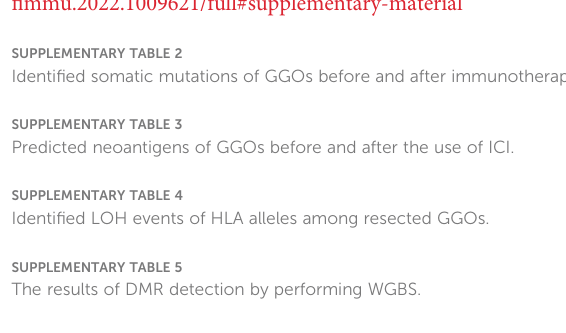
SUPPLEMENTARY TABLE 3 Predicted neoantigens of GGOs before and after the use of ICI.